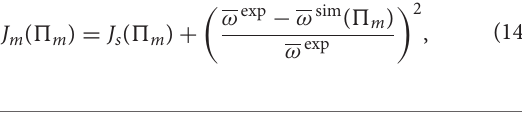
TABLE 4 | Results of the ANOVA comparing the cost functions J e , l m for each of the models. Anova